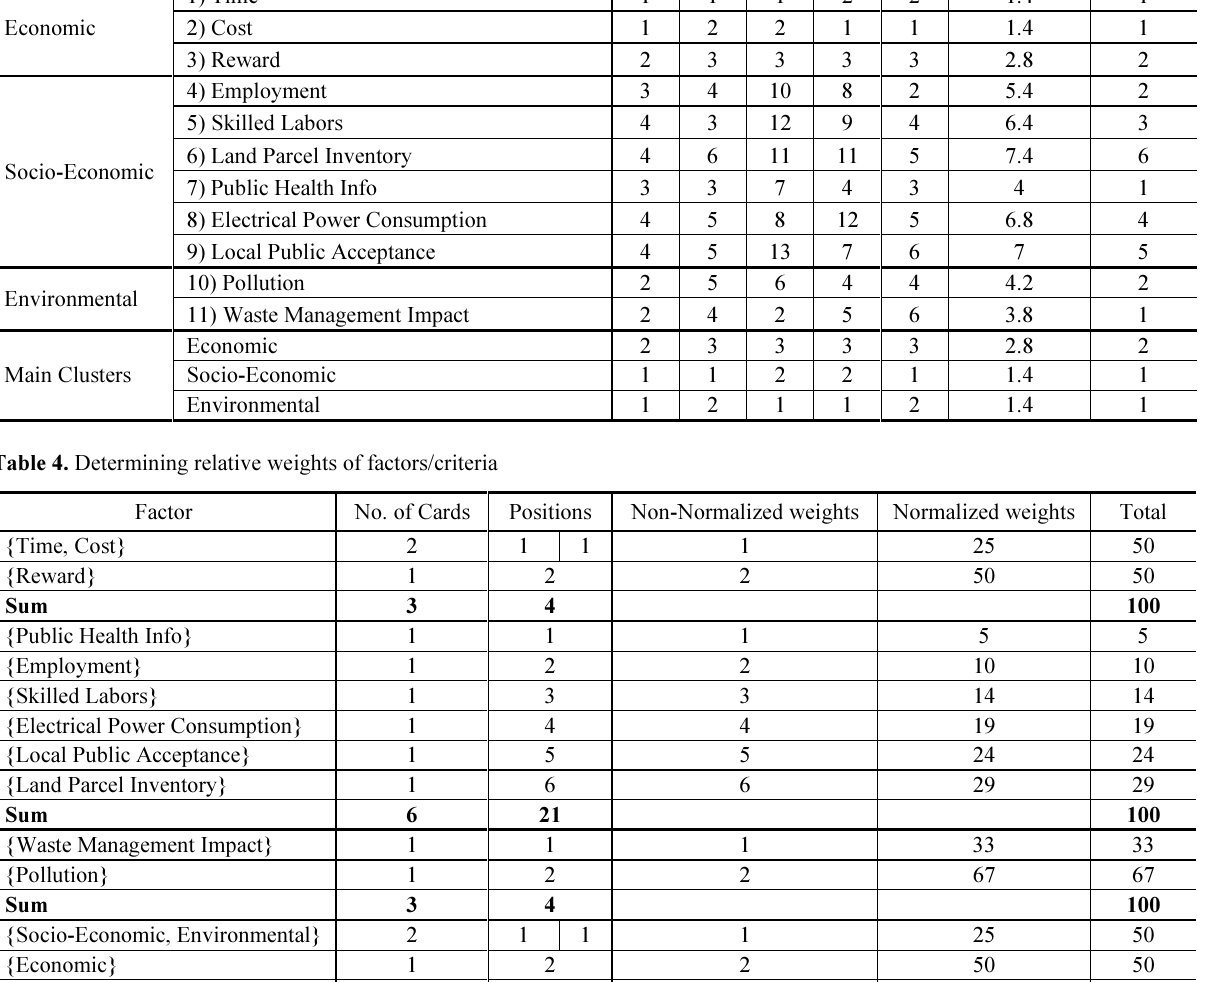
Table 3. Modified list of factors Cluster Factor